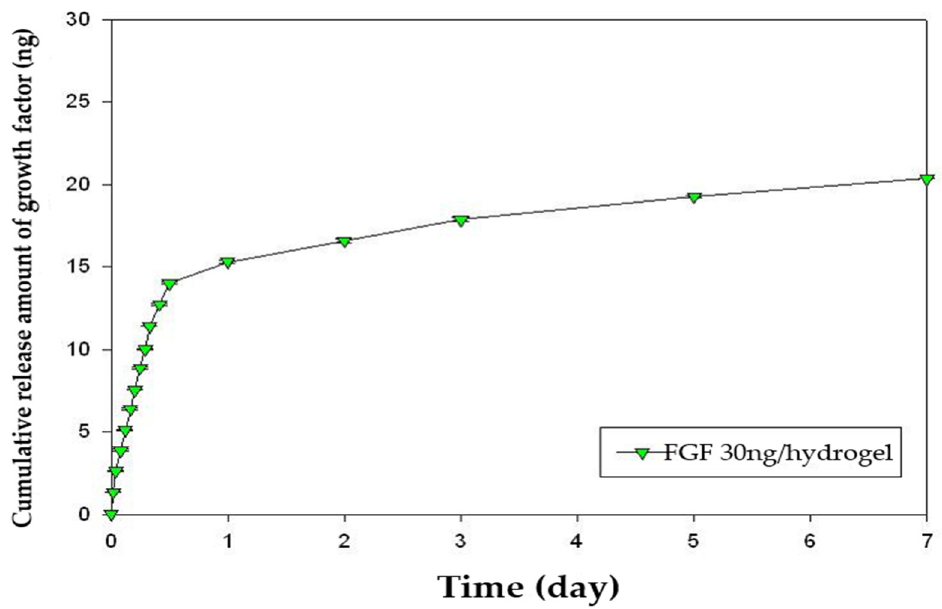
Figure 6. Cumulative release profile of FGF-2 over 7 days. The release kinetics of growth factors was quantified by an enzyme-linked immunosorbent assay (ELISA). FGF-2 was released sustainably for 7 days but significantly during the first 24 h. The released amount of FGF-2 for 7 days was 68%. FGF, fibroblast growth factor.